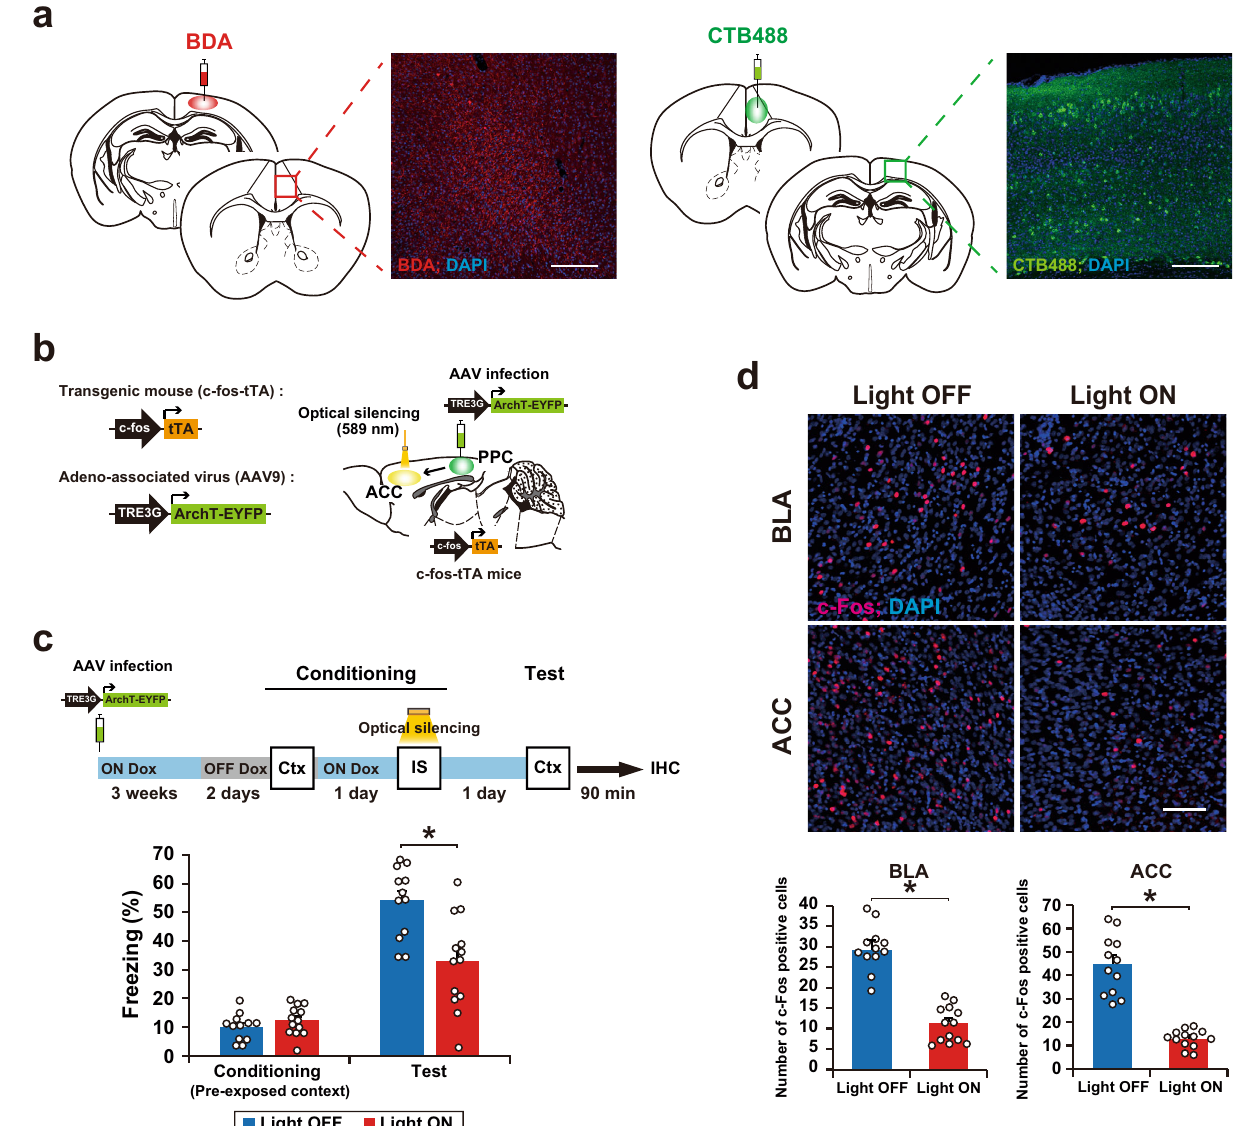
Fig. 7 A PPC – ACC circuit regulates memory association. a Horizontal brain sections of the ACC from a mouse injected with BDA in the PPC, in which neurons were immunostained with streptavidin-Alexa Fluor 555 (red; left). PPC cell axons were detected in the ACC. Horizontal brain sections of the PPC from a mouse injected with CTB488 in the ACC (green; right). CTB488-labeled cells were detected in the PPC. Scale bar, 200 μ m. These immunohistochemical analyses were repeated at least three times independently with similar results. b Schematics showing labeling and manipulation of the PPC – ACC circuit in c-fos-tTA transgenic mice with the AAV9 TRE3G-ArchT-EYFP. c Silencing of cell ensembles during an IS session of conditioning (top). Blue and gray bars indicate the presence or absence of Dox, respectively. Mice were sacri fi ced 90 min after the test for immunohistochemistry (panel d ). The graph shows the freezing level at the conditioning and test session (bottom) (Light OFF, n = 12 mice, Light ON, n = 13 mice) (two-way ANOVA with RM followed by Sidak ’ s post hoc test, session: P < 0.0001, group: P = 0.0100, session × group: P = 0.0003). d Representative image of c-Fos expression 90 min after the test (top). Scale bar, 100 μ m. The proportion of c-Fos-positive cells in the BLA (left) and ACC (right) (Light OFF, n = 12 mice, Light ON, n = 13 mice) (two-tailed unpaired t -test, BLA; P < 0.0001, ACC; P < 0.0001). Error bars represent the mean ± s.e.m. * P < 0.05. Ctx context,